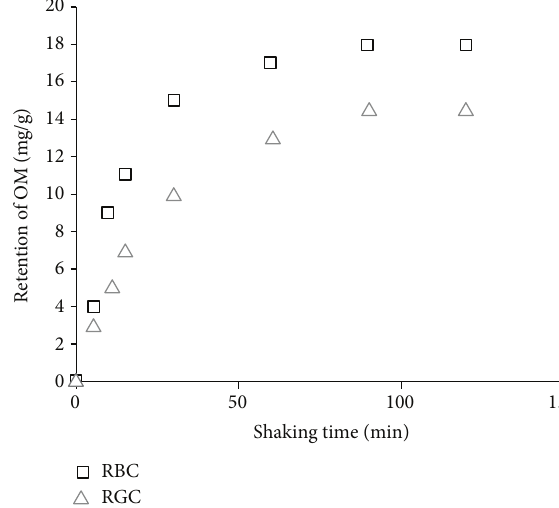
Figure 4: Effect of shaking time on retention of OM present in phosphoric acid using (a) RBC and (b) RGC; (Particle size: 63 𝜇 m;